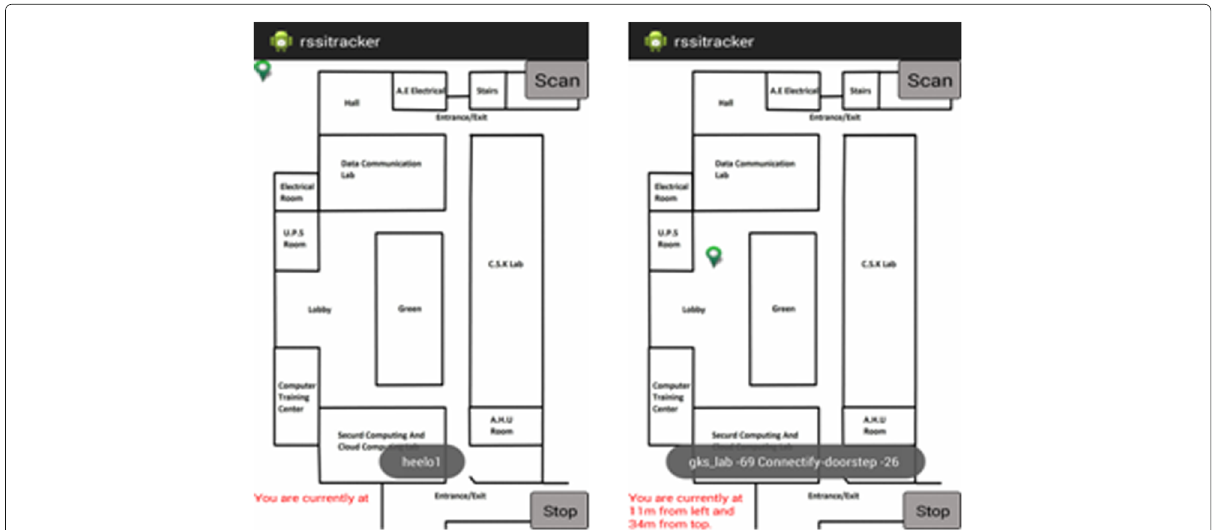
Fig. 5 Tracking for the point [11,34] for testbed-1 with 2